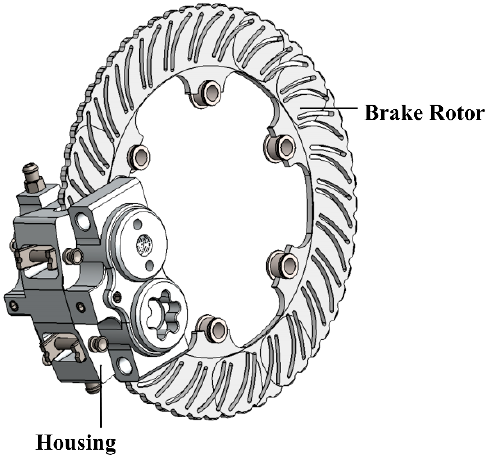
Figure 1. A 3D model of a disc brake design in SolidWorks.